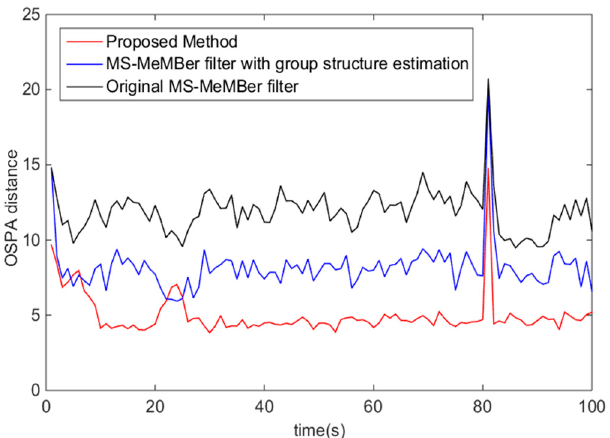
Figure 8. The OSPA distance error for the original MS-MeMBer filter, the MS-MeMBer filter with group structure estimation, and the proposed method with S = 3 sensors each having p j , D = 0.85.